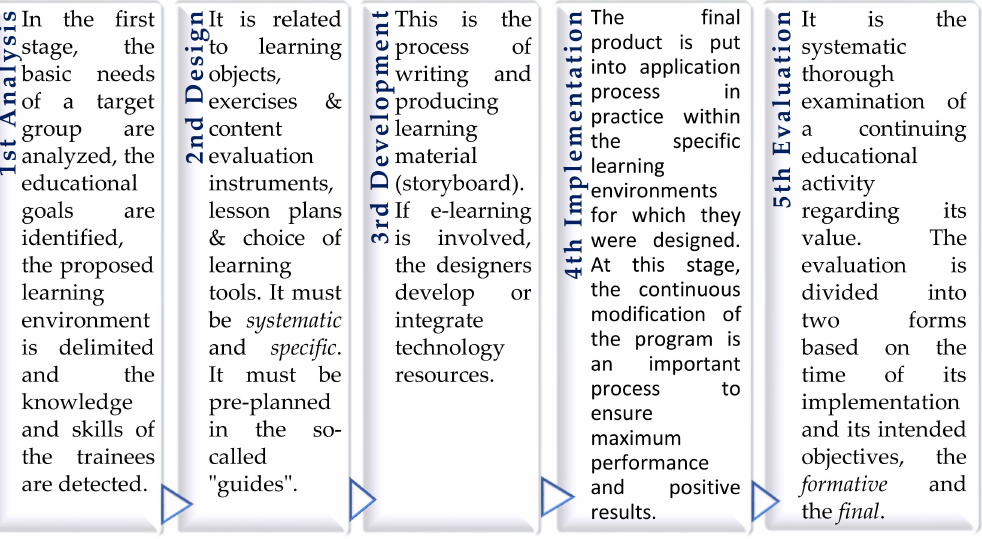
Figure 1. The basic stages of the ADDIE model for the design and development of the learning